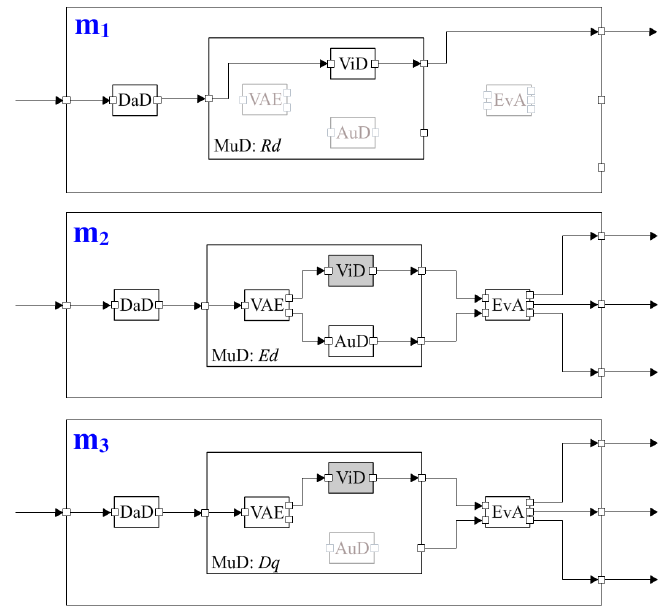
Figure 10. The configurations of different system modes after mode